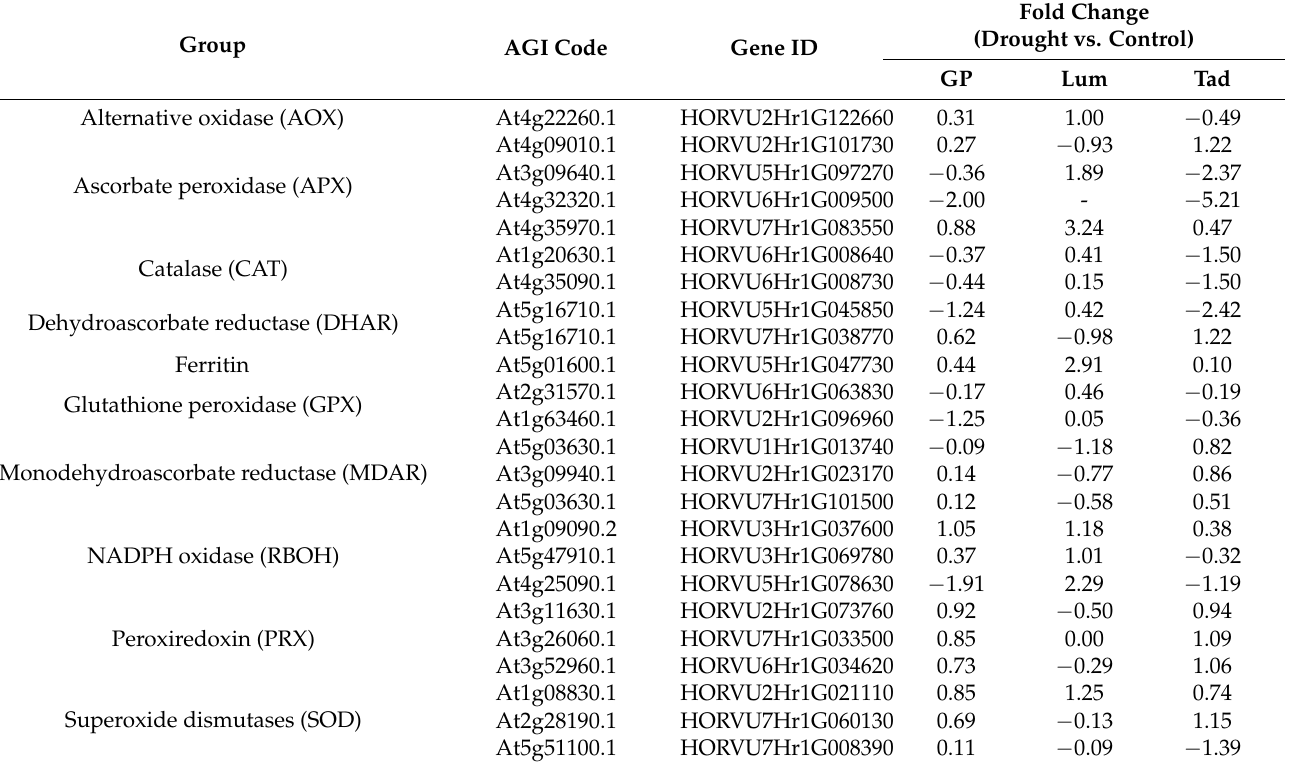
Table 1. Main differentially expressed ROS genes in GP, Lum, and Tad under